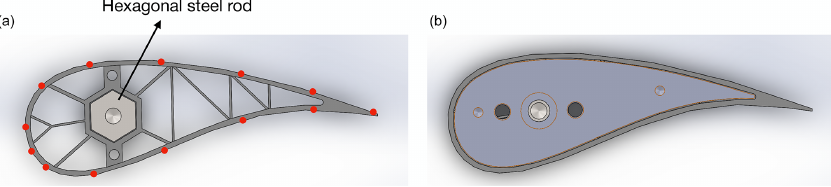
Figure 2. CAD design of the slat cross-section (a) and end plate (b) . Red dots on the left figure indicate the location of the pressure tabs.